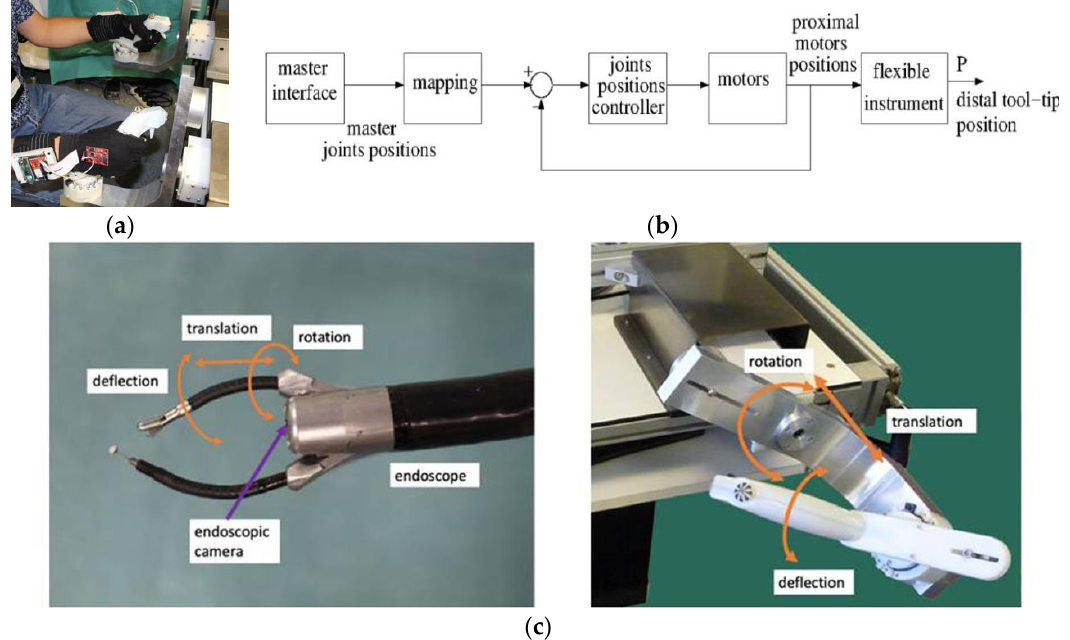
Figure 1. ( a ) Expert wearing the sensor gloves while manipulating the handles of the robotic master/slave system. ( b ) Master-slave control chart of the system. ( c ) Direction and type of tool-tip and control movements.